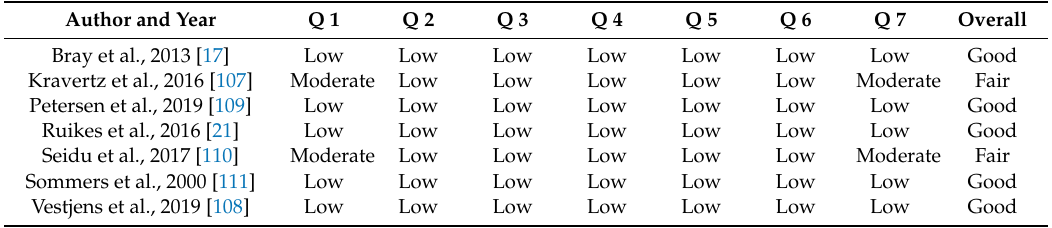
Table A8. Quality assessment of non-randomised controlled studies using Risk of Bias In Non-randomised Studies of Interventions (ROBINS-I)